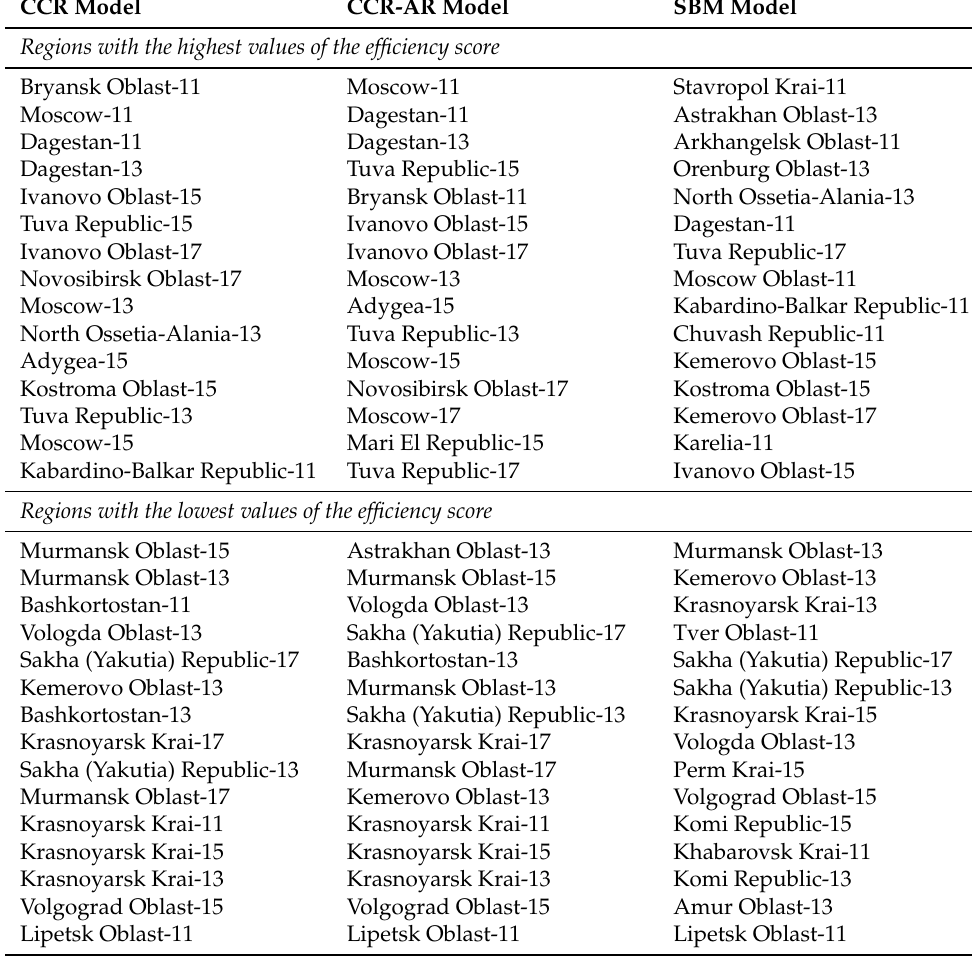
Table 5. Regions with the highest and lowest values of the efficiency score (comparison of 3